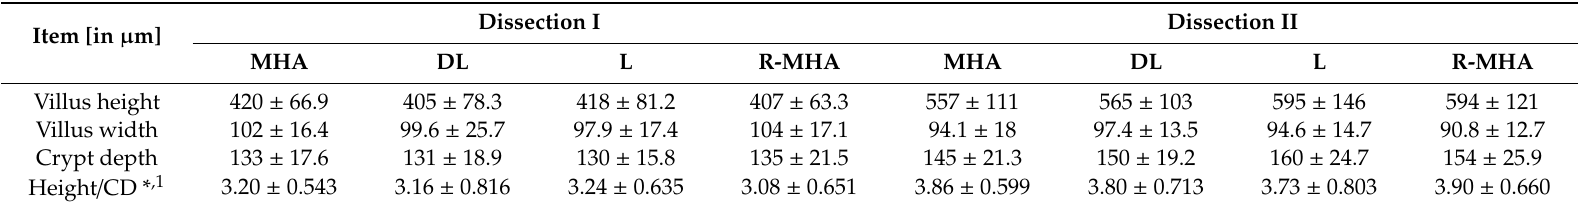
Table 11. Average villus height *, width, crypt depth, and height / crypt depth ratio of the ileum (mean ±